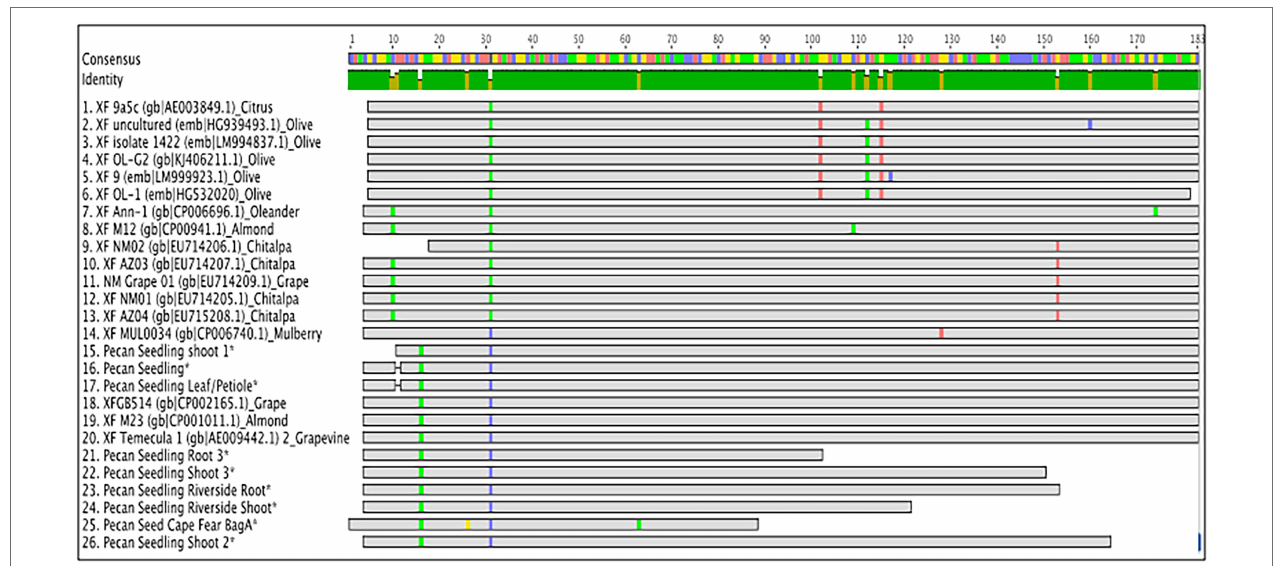
FIGURE 7 | HL amplicon sequence alignment. Geneious Prime sequence alignment of HL amplicons from developing and mature pecan seeds and germinated seedlings compared to HL sequences deposited in GenBank (accession numbers indicated on